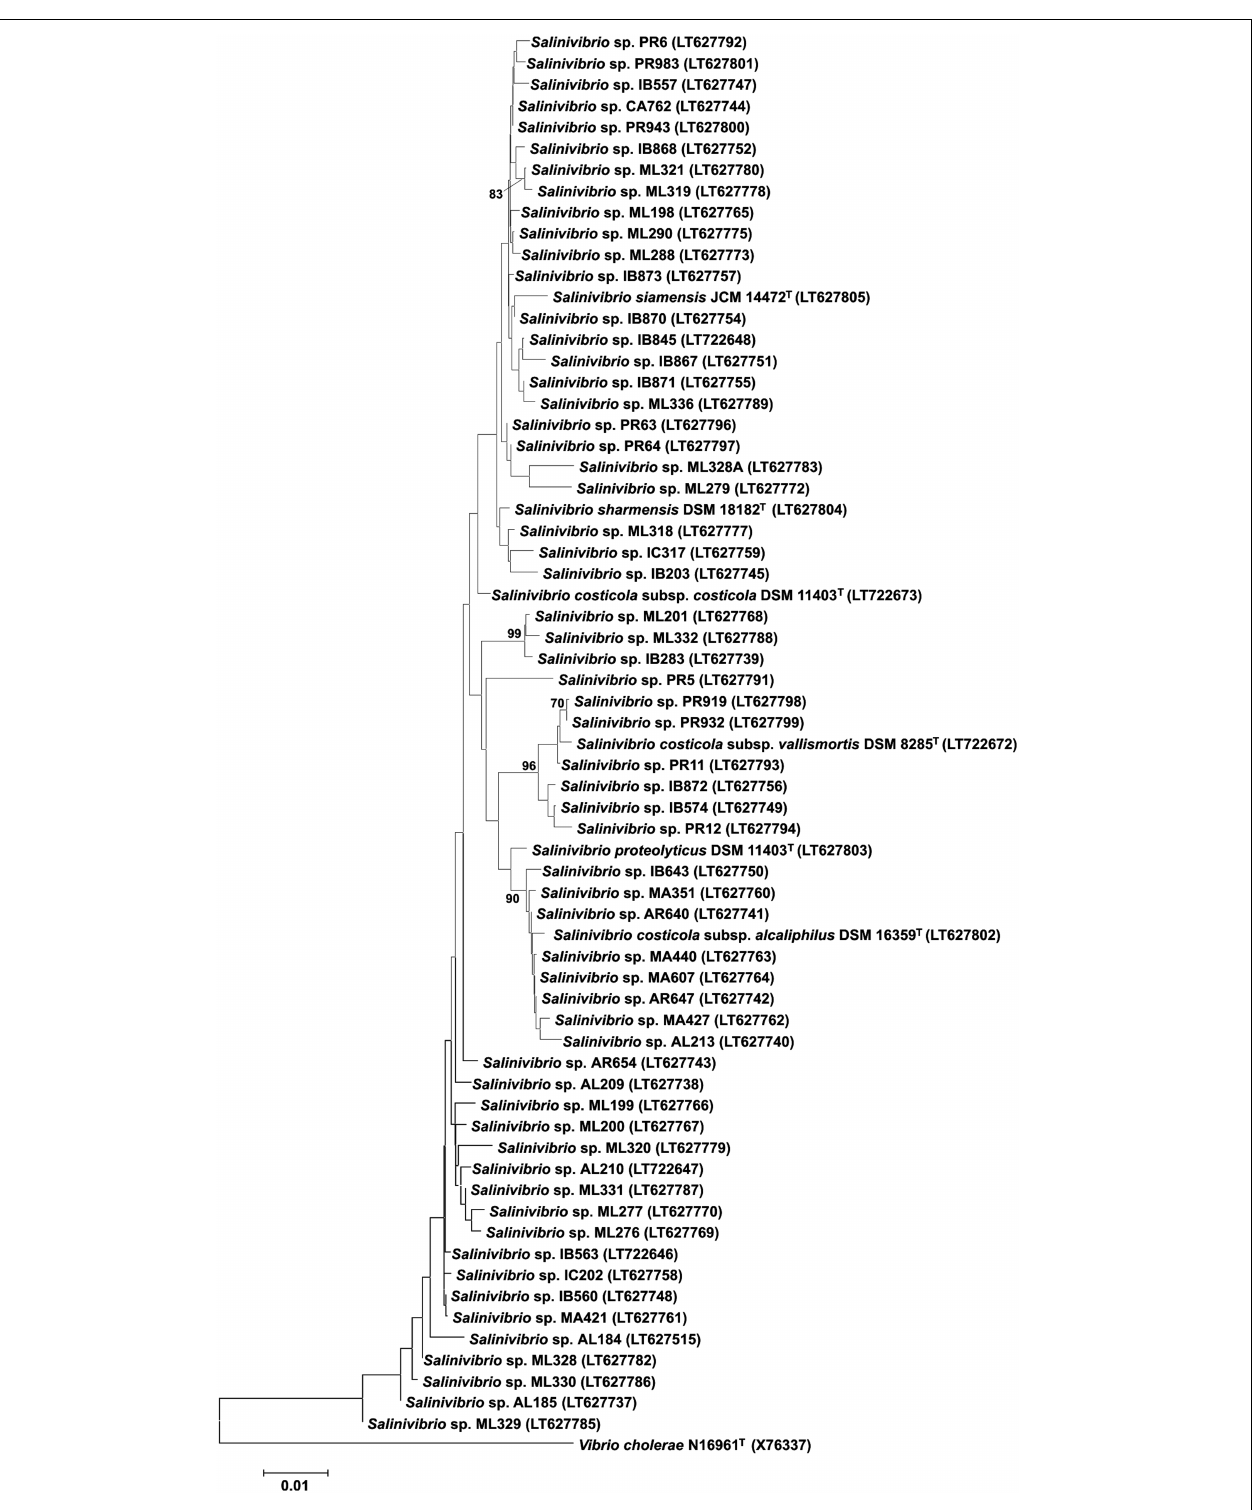
Frontiers in Microbiology |